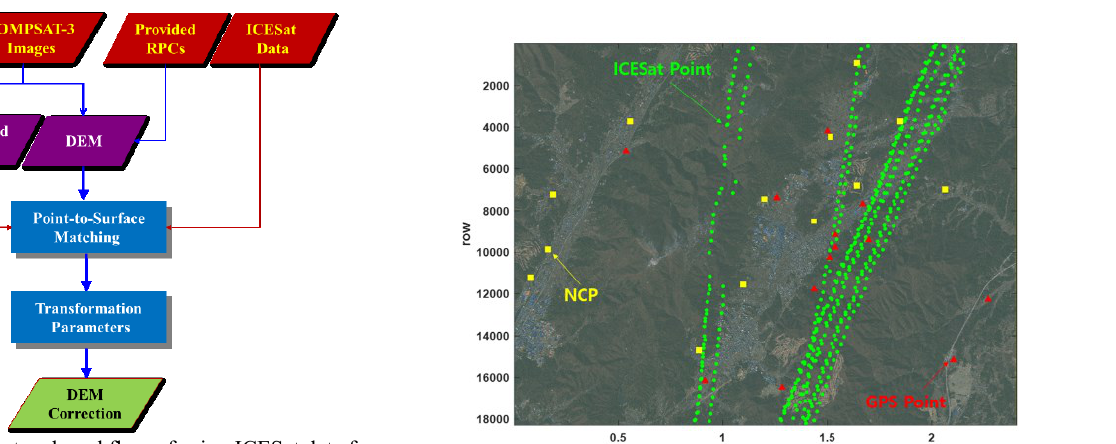
Figure 2. Concept and workflow of using ICESat data for correcting KOMPSAT-3 DEM